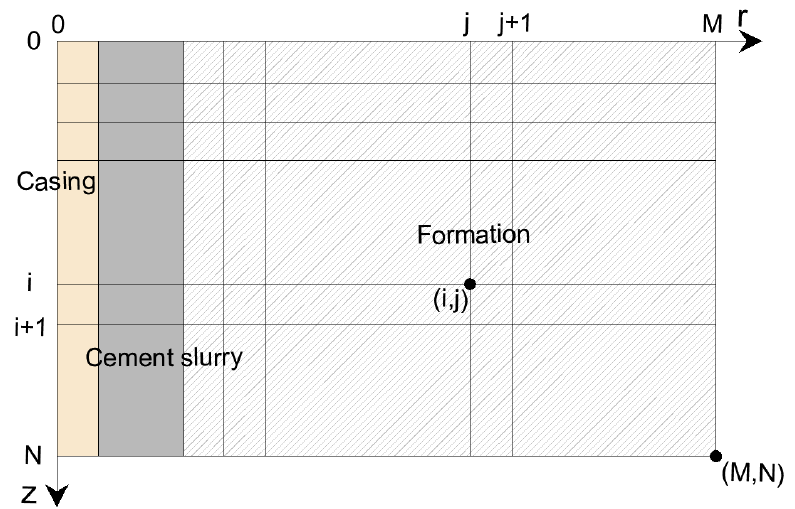
Figure 4. Schematic diagram of grid division.